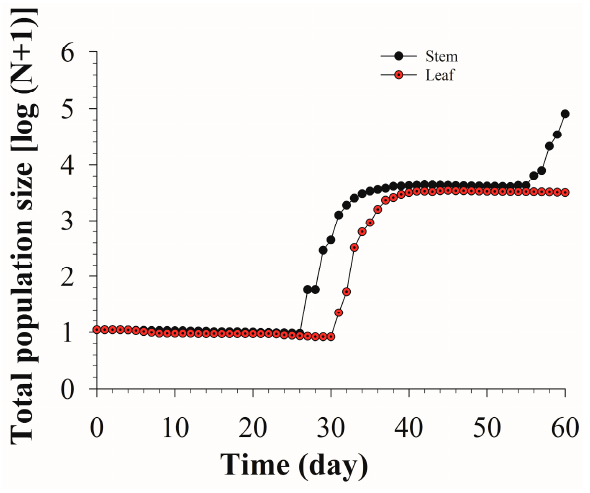
Figure 5. Population projection of S. litura fed on different tissues of asparagus.